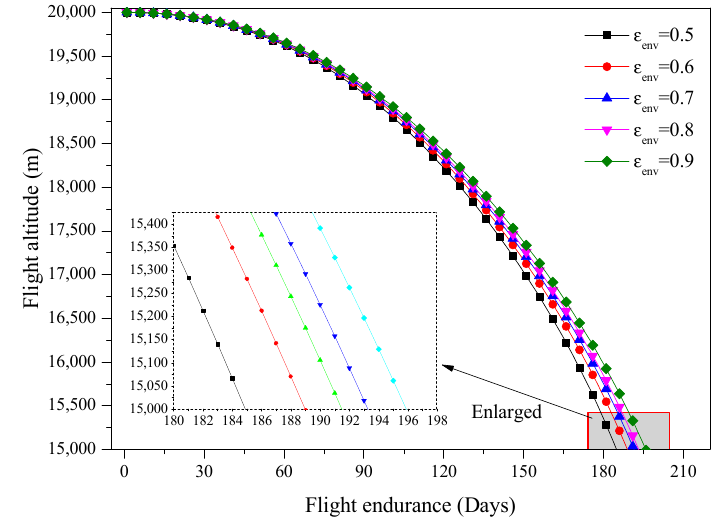
Figure 17. Effects of envelope emissivity on flight altitude.